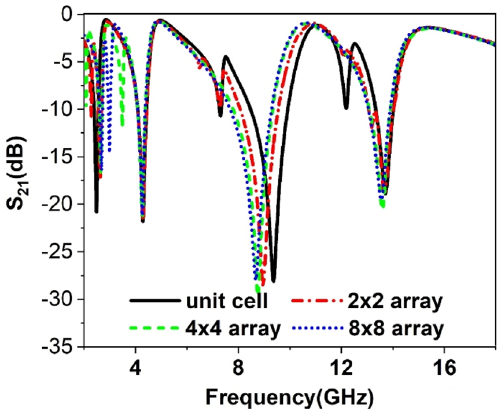
Figure 22. S 21 comparison between the unit cell and different arrays.